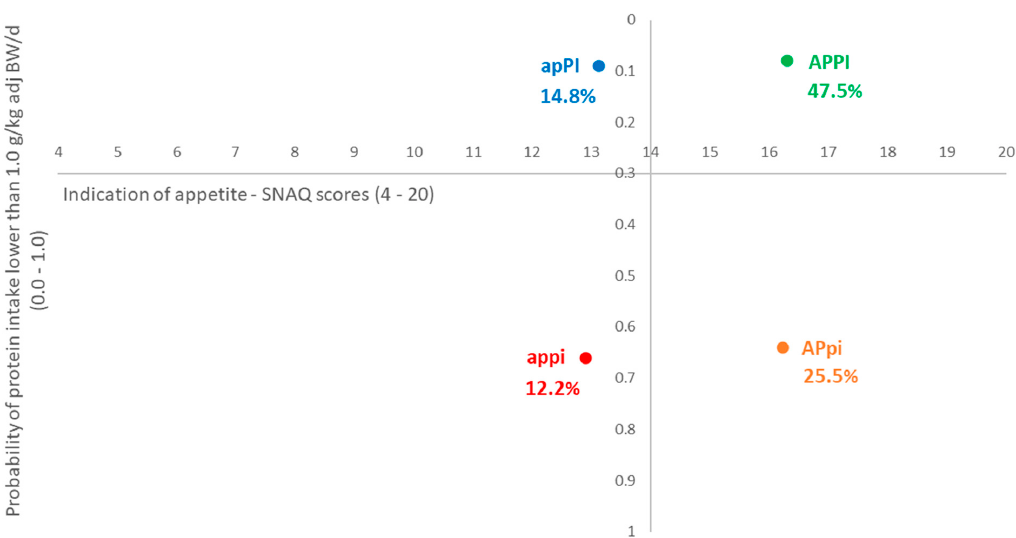
Figure 1. Positioning of the four appetite and protein intake strata based on their median values for the appetite scores (based on simplified nutritional appetite questionnaire) and probability of protein intake lower than 1.0 g/kg adjusted BW/day ( n =1825). appi: poor appetite and lower level of protein intake; APpi: good appetite but lower level of protein intake; apPI: poor appetite but higher level of protein intake; and APPI: good appetite and higher level of protein intake.